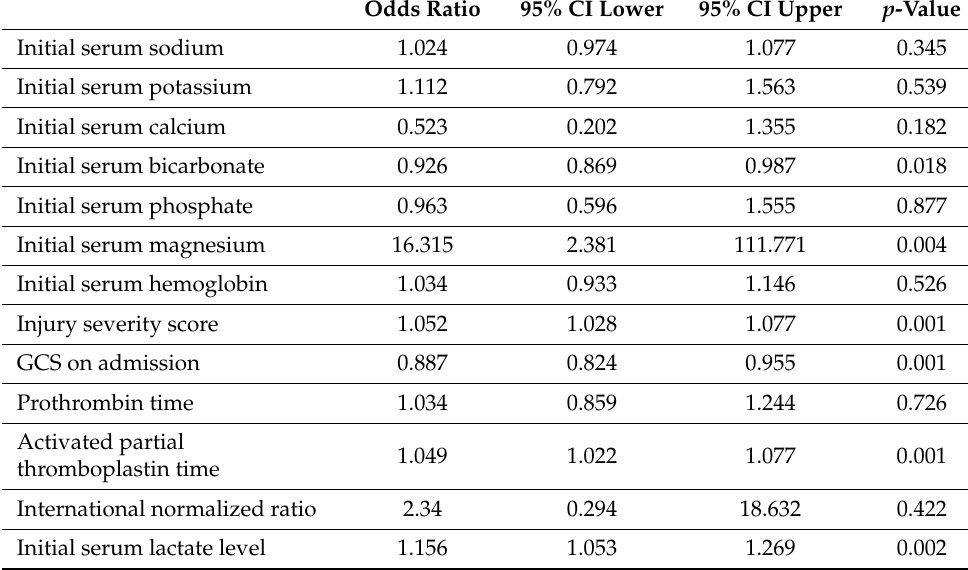
Table 6. Multivariable logistic regression analysis for the predictors of mortality in Traumatic Brain Injury using the clinical severity and laboratory variables on